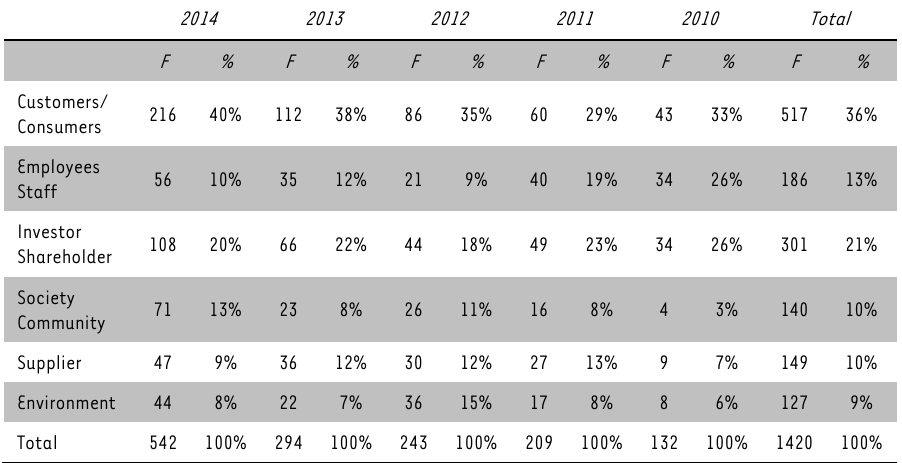
TABLE 6: Pick n Pay stakeholder frequencies from 2010 to